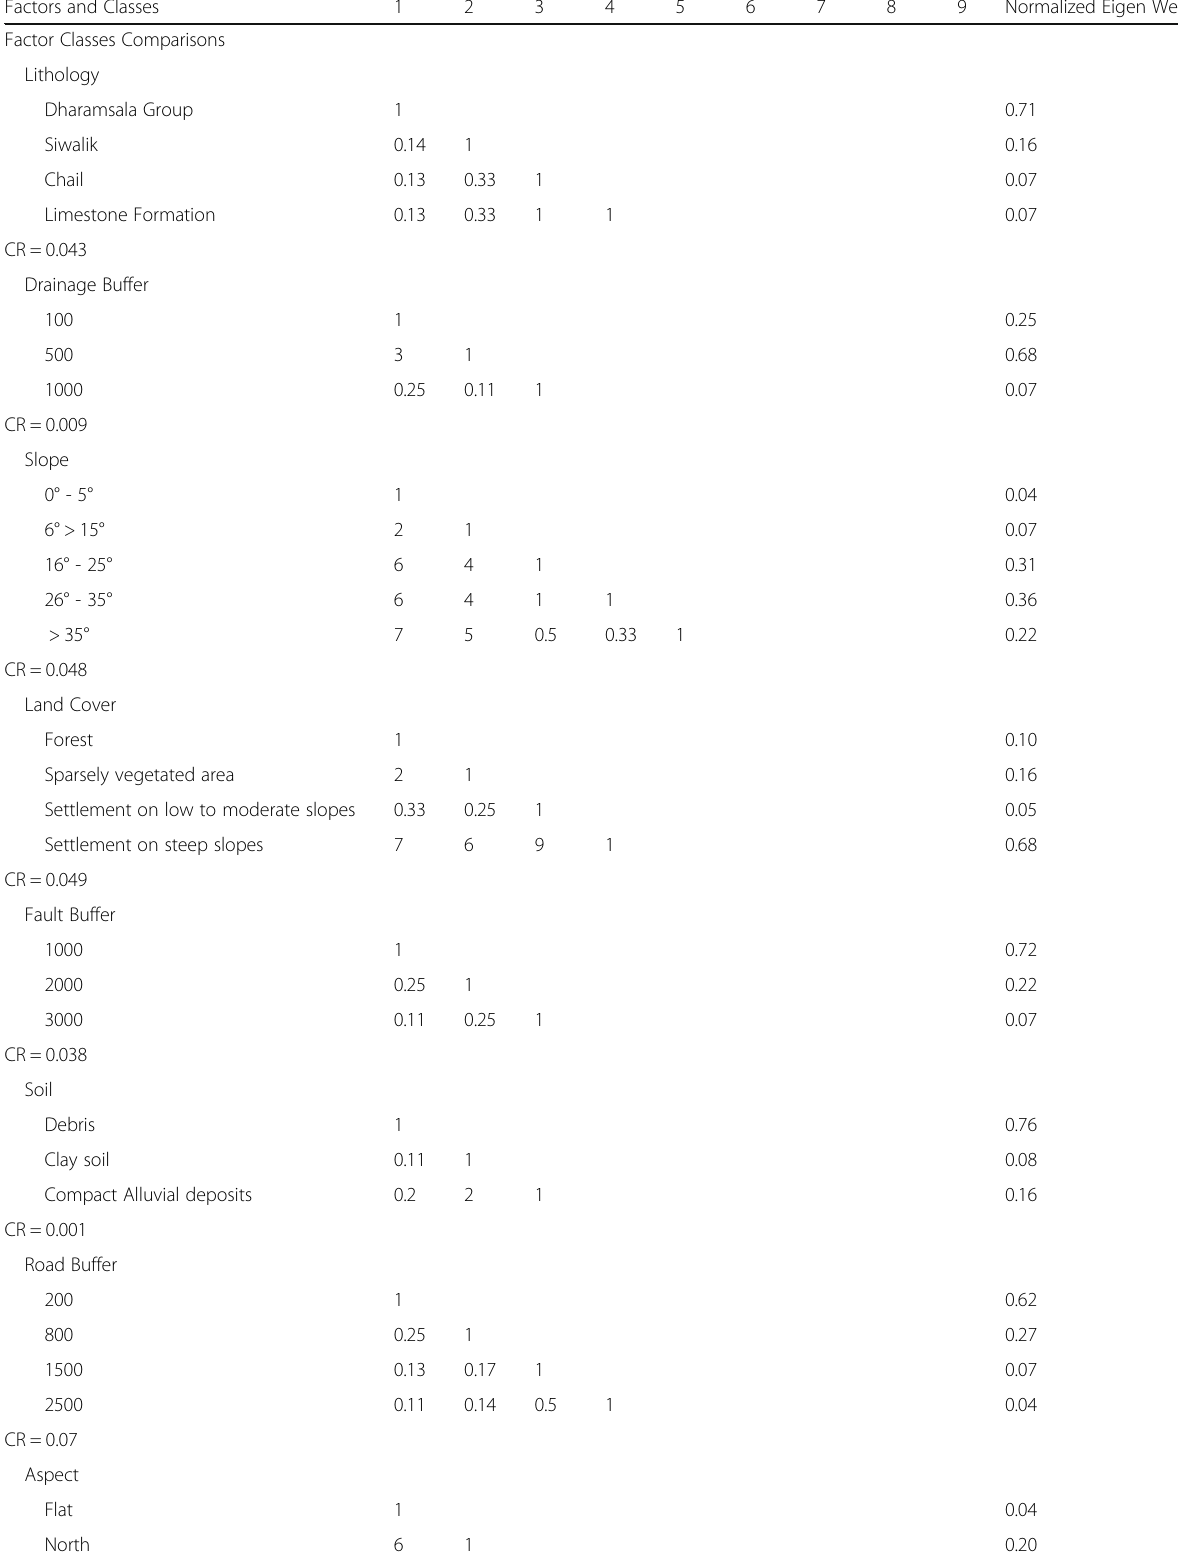
Table 4 Comparison matrix of factor classes and the factors based on analytical hierarchy process